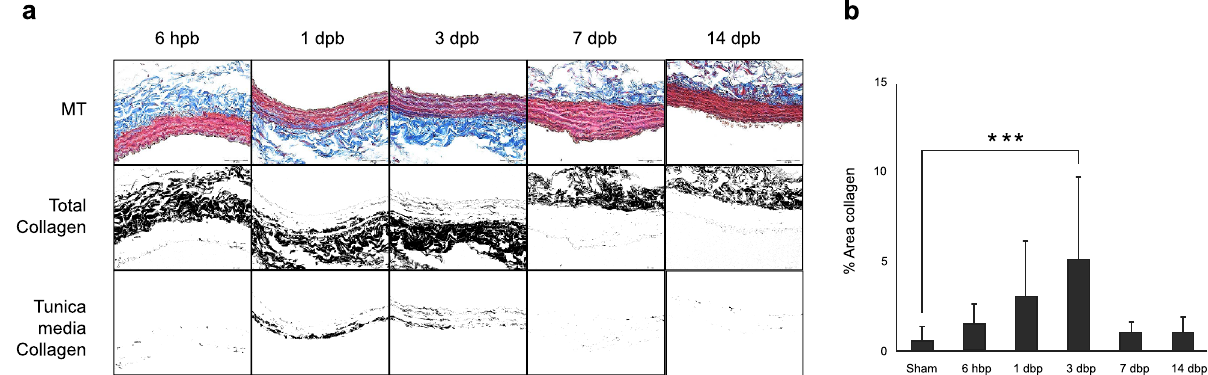
Figure 3. ( a ) Masson’s trichrome stain shows significantly increased collagen expression within the tunica media smooth muscle of the carotid artery at 1 day and 3 days after burn compared to sham-treated animals. Top row: Masson’s trichrome stain (MT); collagen fibers stain blue, muscle fibers stain red. Middle row: Color thresholding ImageJ method shows total collagen in black. Bottom row: Adventitia tissue digitally removed, leaving only collagen stained within the tunica media. ( b ) Quantification of the percent area occupied by collagen within tunic media; data is presented as mean % Area Collagen ± SD. Scale bar = 50 µm. * p < 0.05,